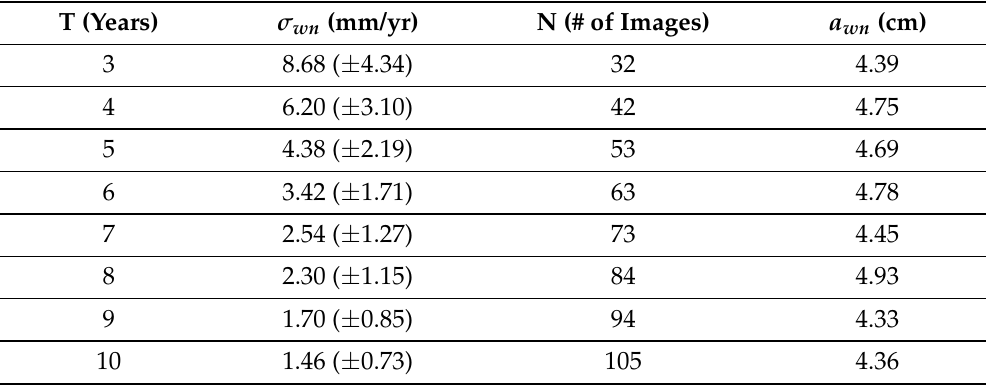
Table 2. Estimated white noise in the case of a combination of vertical stratification and turbulence mixing components (Figure 7c), with the formula (Equation (6)) described by Zhang et al. (1997) [69], where T is the time-series length in number of years, σ wn is the detection threshold taken from Figure 7c, N is number of images, and a wn is the estimated white noise. T (Years) σ wn